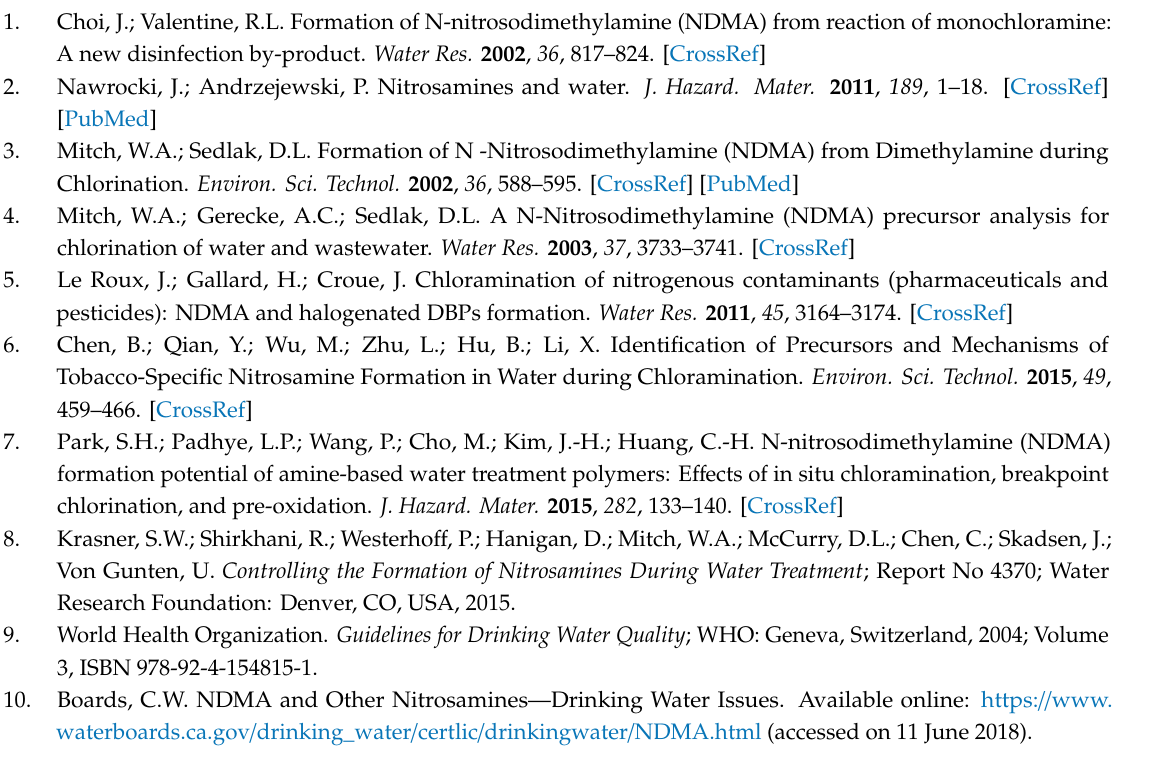
Table S1. Structure and properties of the N-nitrosamines considered in this work. Table S2: Compilation of MDLs reported in the literature for the determination of nitrosamines in water. Figure S1. Isobaric interference for NMEA in PCI acquisition in centroid (A) and profile modes (B). Extracted ion chromatograms (EIC) with ± 50 ppm. Figure S2: Calibration curves obtained by: (a) GC-EI—MS (IT), (b) GC-PCI—MS (IT), (c) GC-EI-MS(QTOF), and (d)